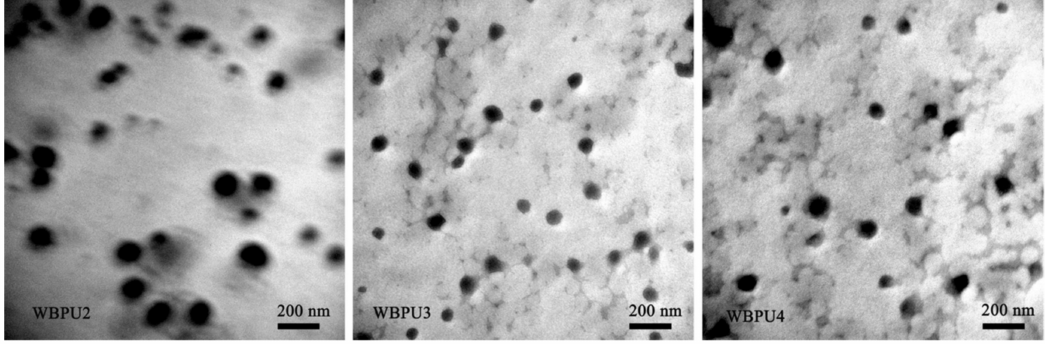
Figure 8. TEM micrographs of WBPU2, WBPU3, and WBPU4 dispersions [22]. Copyright © (2020) Springer